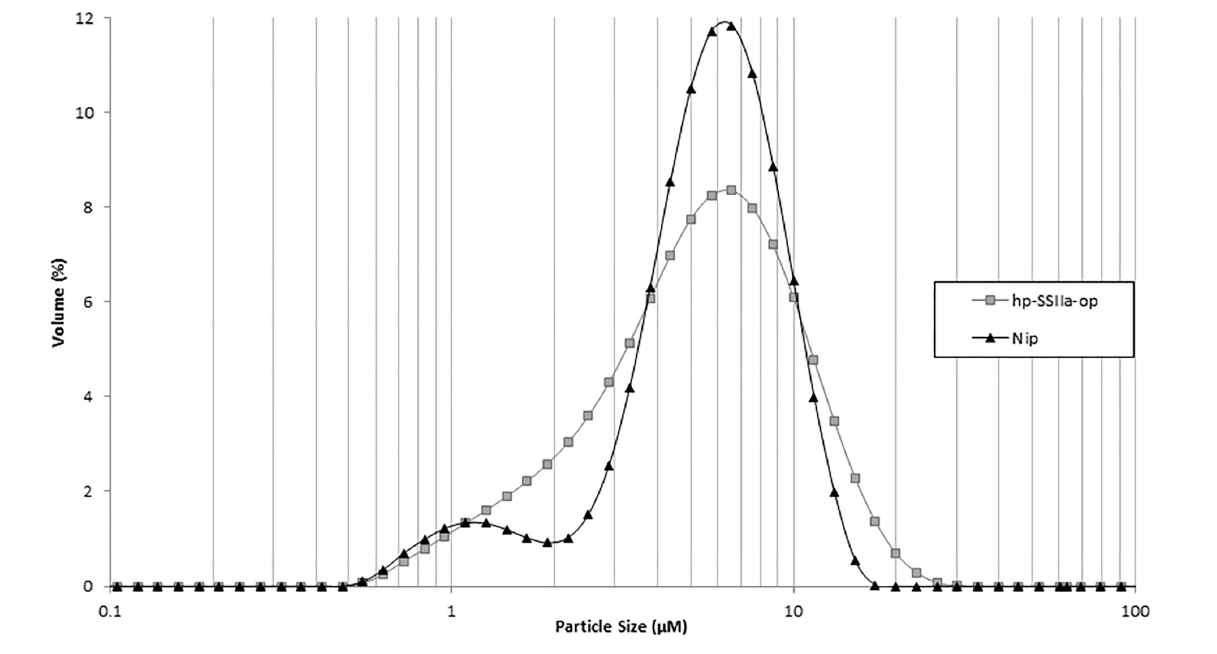
Despite pronounced alterations in starch granule